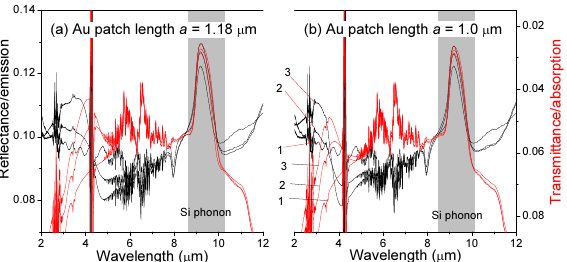
Figure 5. FTIR reflectance (left vertical axis, normal scale, black lines) and transmittance (right vertical axis, reversed scale, red lines). The Si phonon band is displayed as the emission in the reflectance spectrum and absorption in the transmittance spectrum. Line 1: SiO 2 /Si, Line 2: Au/Ti/SiO 2 /Si, L y = 5.0 µ m, Line 3: Au/Ti/SiO 2 /Si, L y = 2.5 µ m. ( a ) 1.18 × 0.24 × 0.05 µ m 3 , L x = 1.2 µ m, L y = 5.0 µ m; 1.18 × 0.24 × 0.05 µ m 3 , L x = 1.1 µ m, L y = 2.5 µ m. ( b ) 1.0 × 0.26 × 0.05 µ m 3 , L x = 1.22 µ m, L y = 2.5 µ m; 1.0 × 0.26 × 0.05 µ m 3 , L x = 1.12 µ m, L y = 5.0 µ